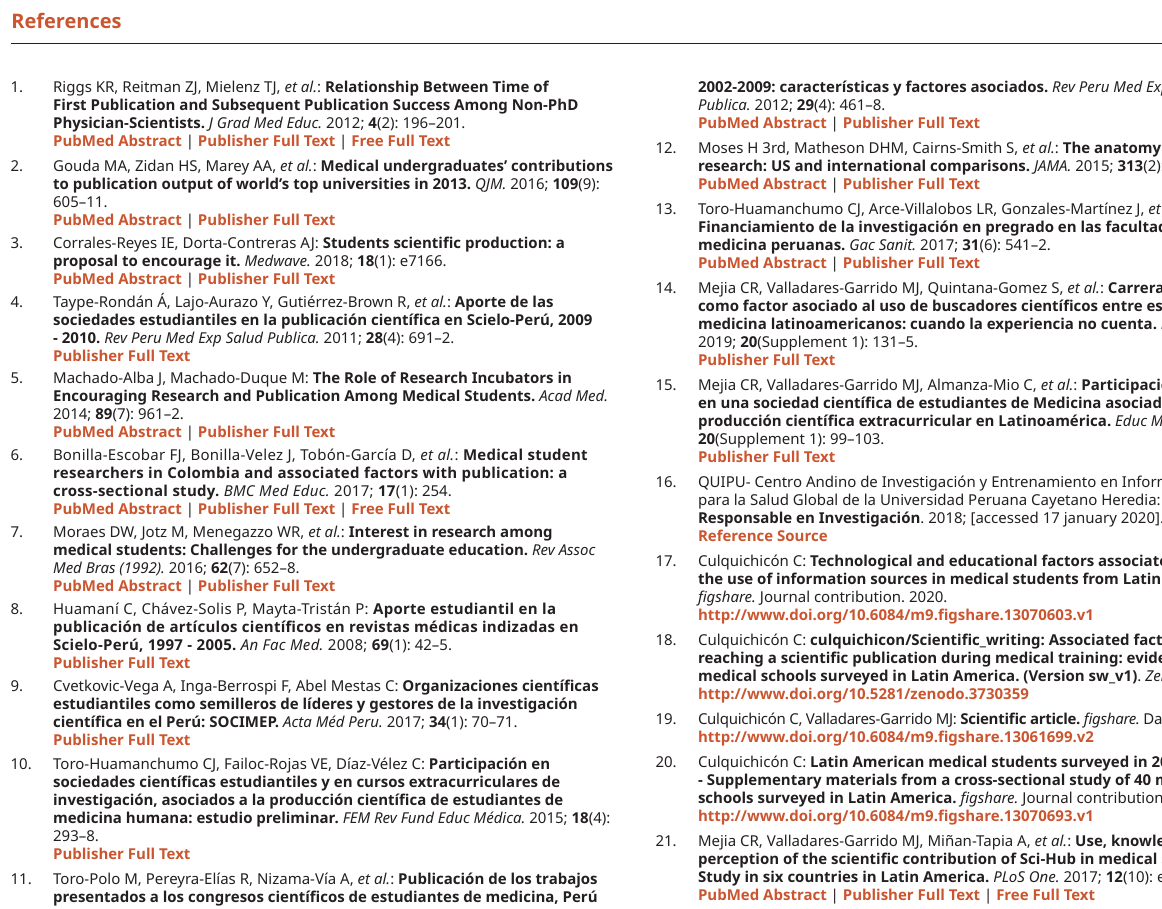
Figshare: Latin American medical students surveyed in 2016 - Supplementary materials from a cross-sectional study of 40 medical schools surveyed in Latin America.